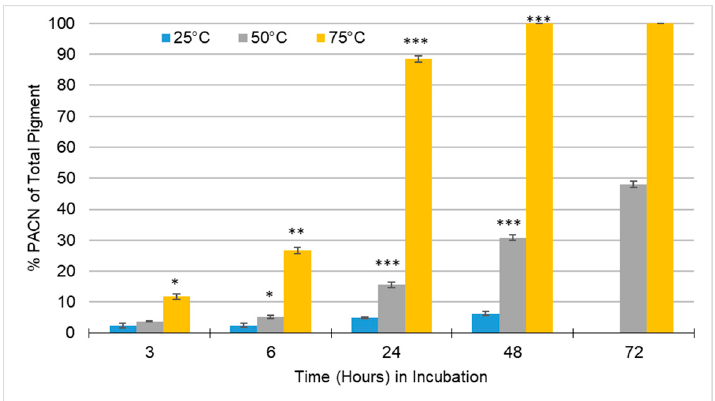
Figure 3. Average percentage of pyranoanthocyanin (PACN) of total pigment of samples with caffeic acid incubated over time at 25 °C, 50 °C, and 75 °C. Calculated by Equation (4). Sample incubated at 25 °C for 72 h was not measured because of minimal PACN present and sample loss. Error bars represent the standard deviations. Significant difference from 25 °C incubation for the same incubation time with * p < 0.05; ** p < 0.01; *** p < 0.001.